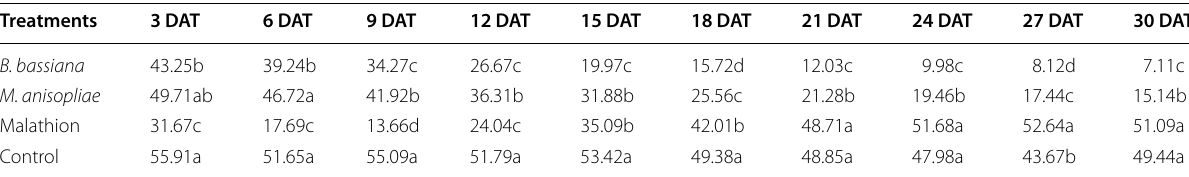
Means followed by the same letter in each column are not significantly different according to HSD ( P